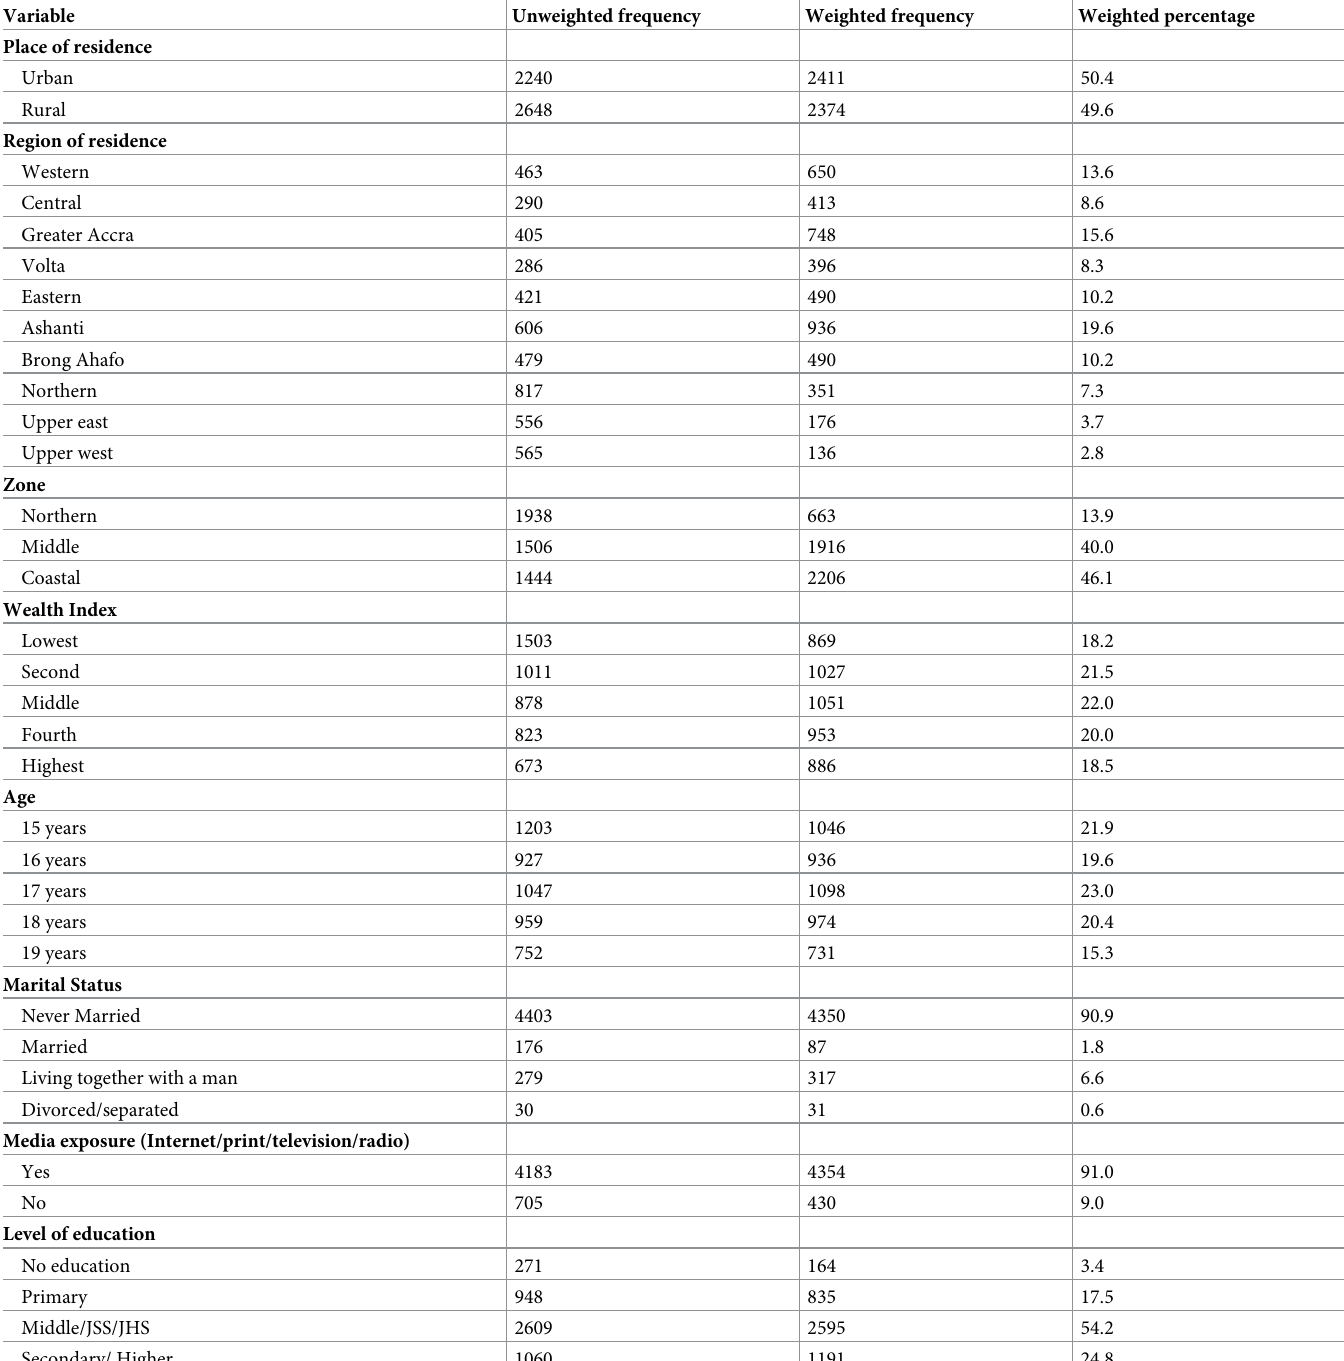
Table 2. Characteristics of study participants (adolescents aged 15–19